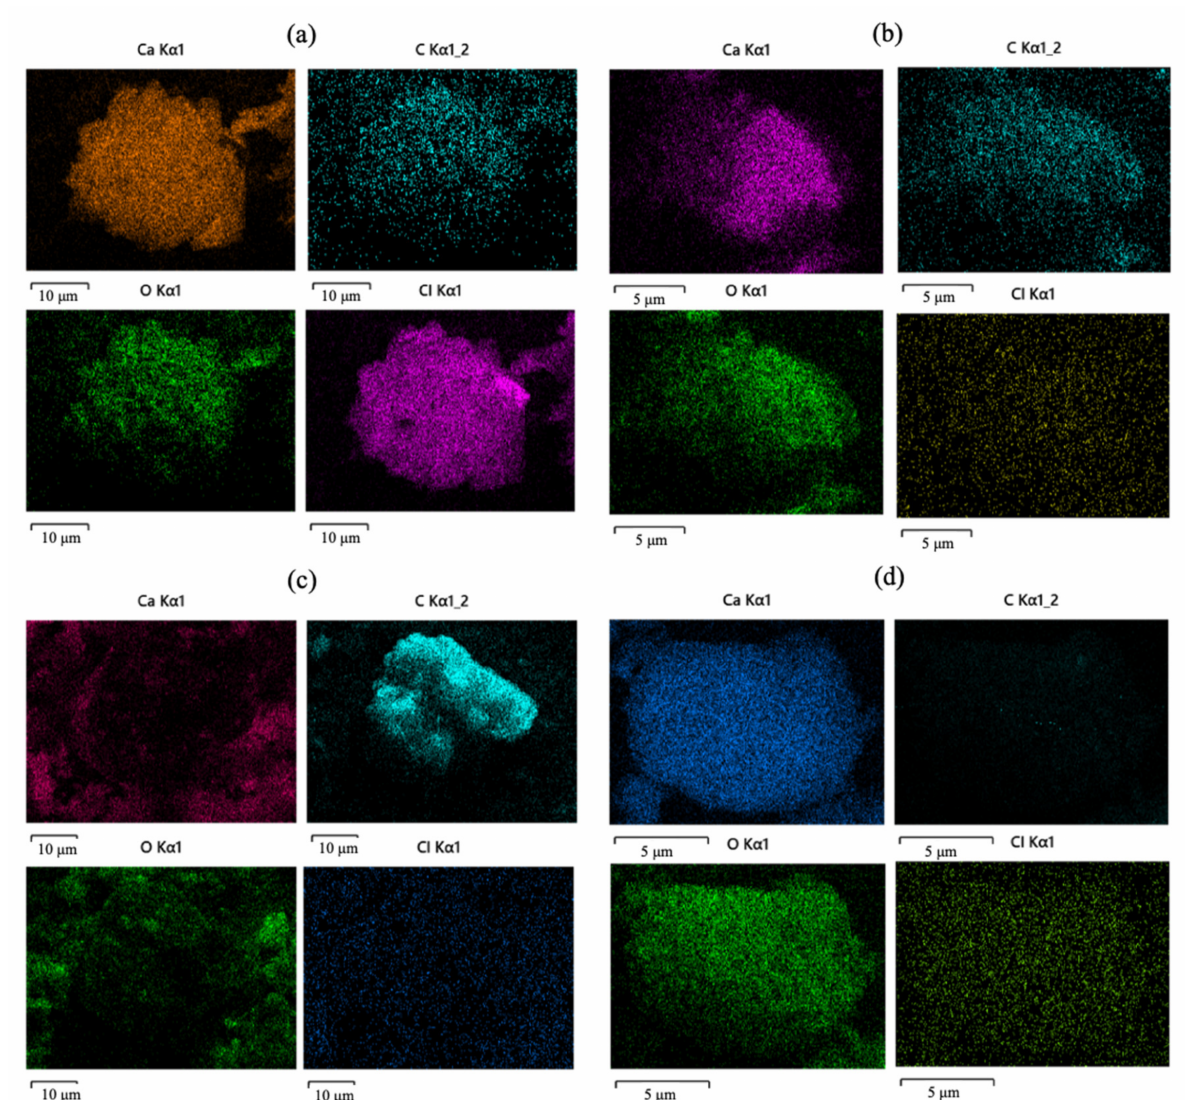
Figure 6. SEM/EDS of raw fly ash ( a ), UAW by citric acid treated fly ash ( b ), UAW by ascorbic acid treated fly ash ( c ), and UAW by EDTA-Na 2 treated fly ash ( d